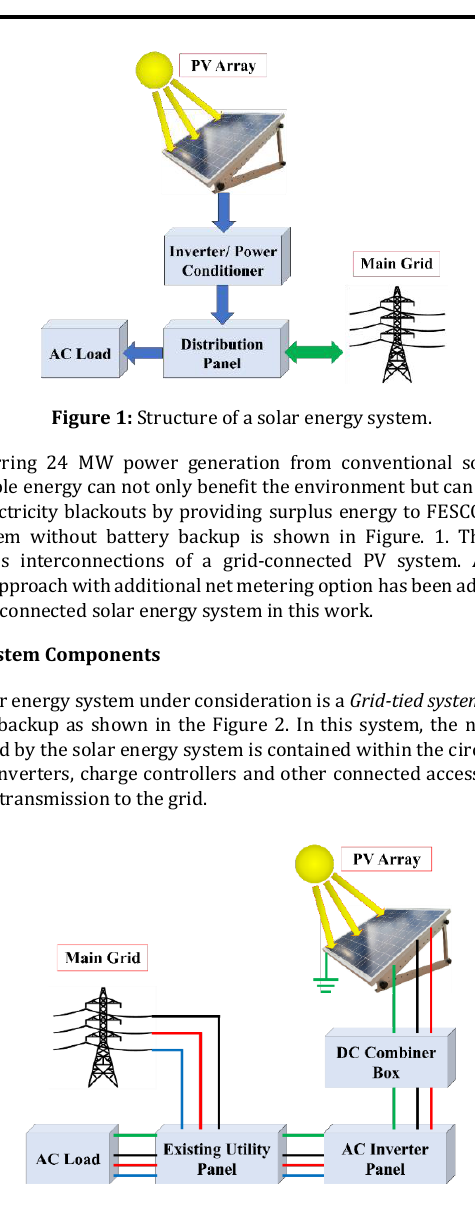
Figure 2: d Grid tie PV without Battery